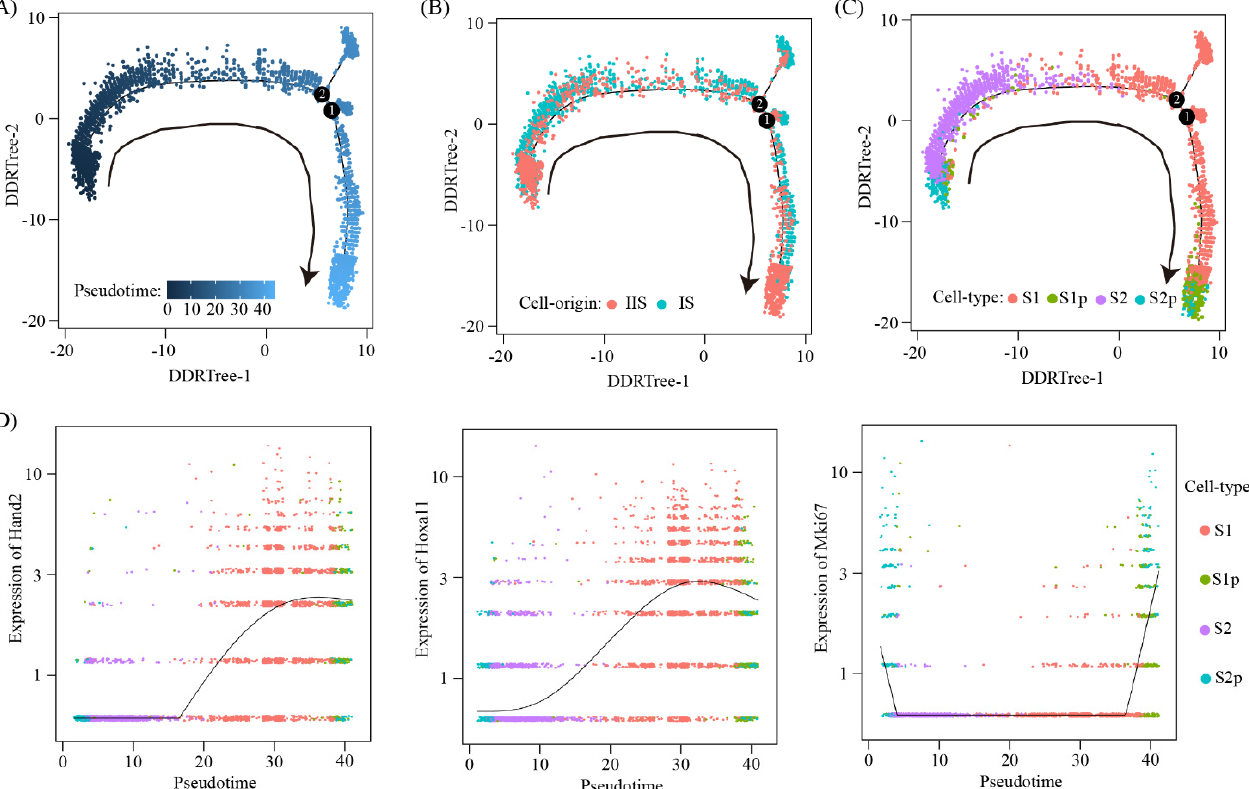
Figure 7. Pseudotime ordering of stromal cells: ( A – C ) The distribution of pseudotime ( A ), cell origin ( B ) and cell type ( C ) across the reconstructed trajectory. The numbers inside the black circles represent the different cell status numbers identified in the trajectory analysis; ( D ) line plots showing gene expression dynamics of Hand2, Hoxa11 and Mki67 in the pseudotime